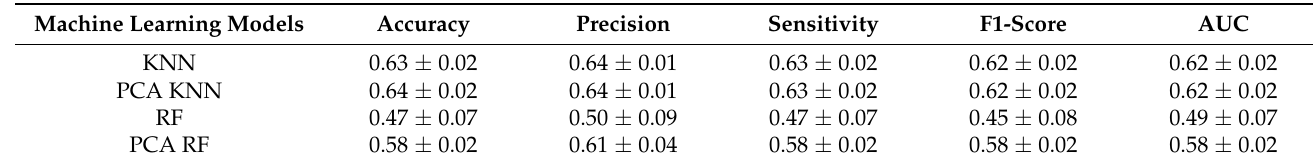
Table 2. The outcome of the radiomics-based machine learning models.